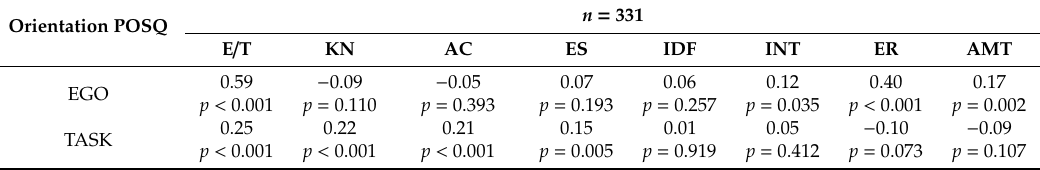
Table 3. Correlations of POSQ task subscale and ego subscale with the TEOSQ goal orientation and the SMS-28 motivation components.